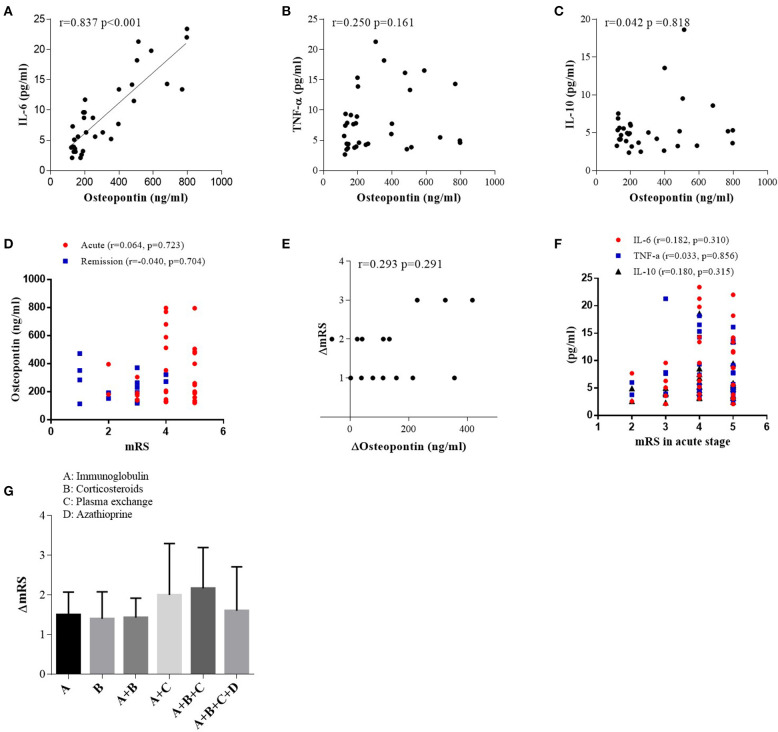
Correlations between cerebrospinal fluid osteopontin (CSF OPN) and (A) interleukin (IL)-6, (B) tumor necrosis factor alpha (TNF-α), (C) IL-10, (D) max mRS scores in acute stage, and (D) CSF OPN and mRS scores in remission of anti-N-methyl-d-aspartate receptor (anti-NMDAR) encephalitis patients. Correlation was found between CSF OPN and IL-6 in acute stage (r = 0.837, p < 0.001). (E) Association between the reduction in mRS scores and the decrease in CSF OPN [ΔmRS = mRS (acute stage) – mRS (follow up), ΔOP n = OPN (acute stage) – OPN (follow up)]. No association was found between ΔOPN and ΔmRS in patients with anti-NMDAR encephalitis (r = 0.293, p = 0.291). (F) Correlations between CSF IL-6, TNF-α, IL-10, and mRS scores in acute stage. No association was found between mRS scores and CSF IL-6 (r = 0.182, p = 0.310), TNF-α (r = 0.033, p = 0.856), or IL-10 (r = 0.180, p = 0.315) in acute stage. (G) The influence of acute therapy on changes of mRS scores.